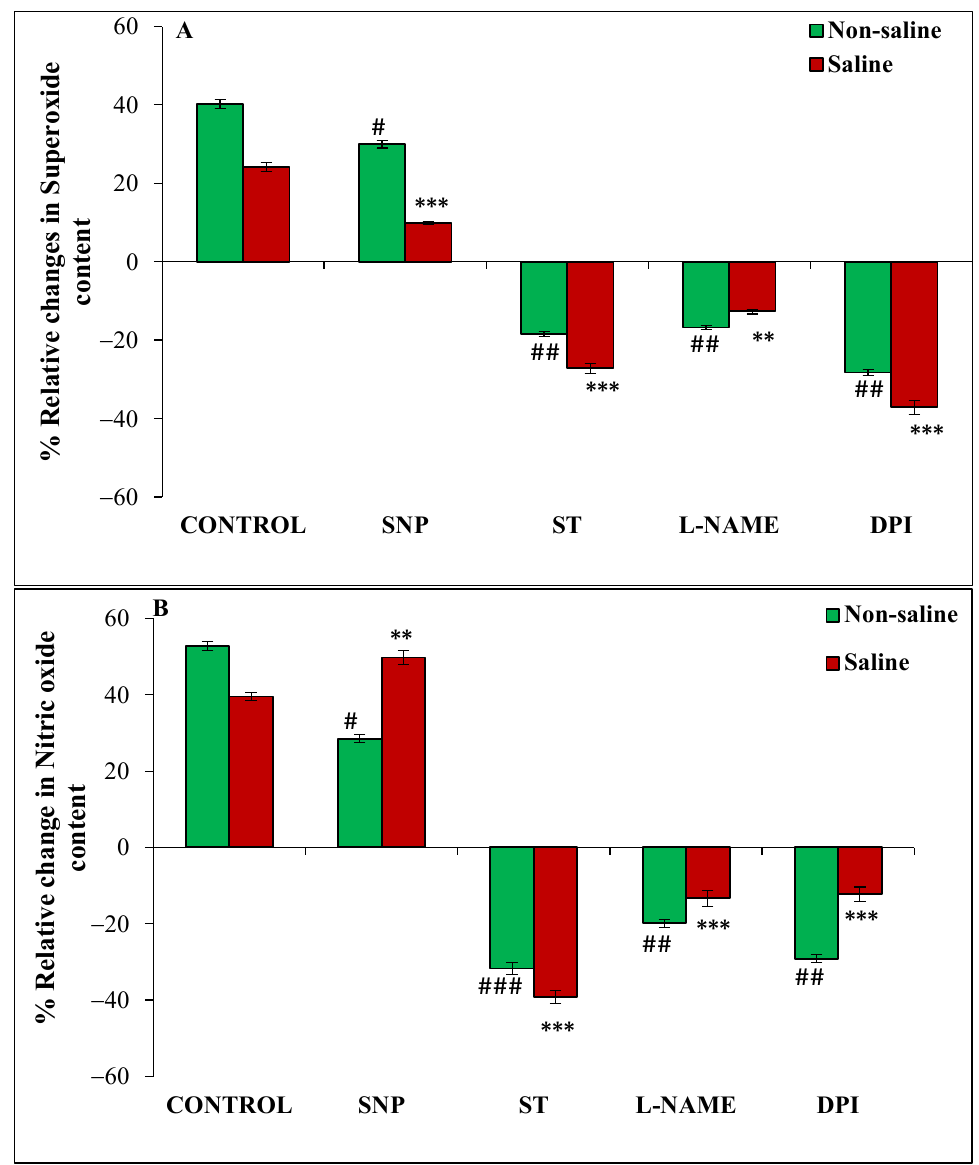
Figure 4. Relative change (%) in superoxide radical ( A ) and nitric oxide( B ) content of magnetoprimed over unprimed seeds kept for 24 h in different modulators of NO and ROS production under non-saline and saline conditions. The data are represented as mean values of relative change ± SE (n = 3). ### p < 0.001, ## p < 0.01, # p < 0.05 shows significant difference amongst the relative change in the seeds grown in control with the seeds grown in different modulators of NO/ROS production under non-saline conditions; *** p < 0.001, ** p < 0.01 shows significant difference amongst the relative change in the seeds grown in control with the seeds grown in different modulators of NO/ROS production under saline conditions.